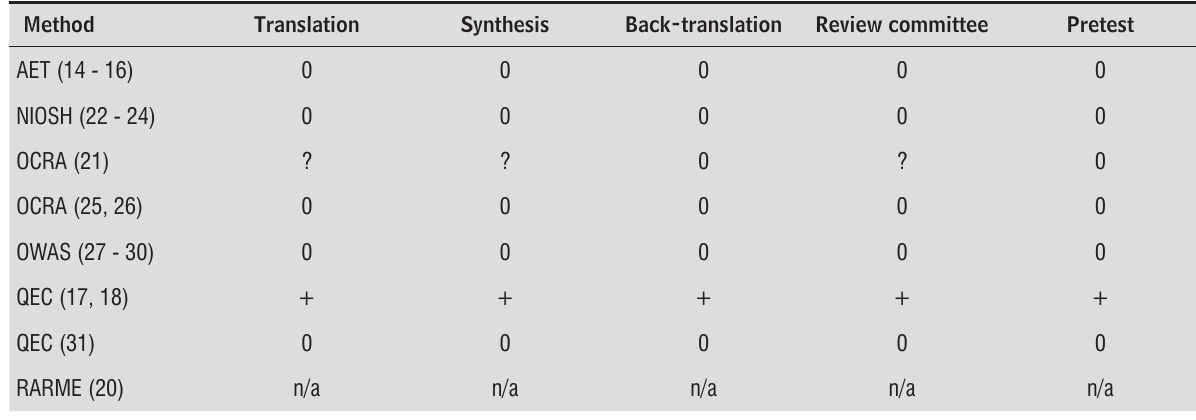
Table 3 - Analysis of translation and cross-cultural adaptation procedures of observational methods according to Guide- lines for the Translation and Cross-Cultural Adaptation of